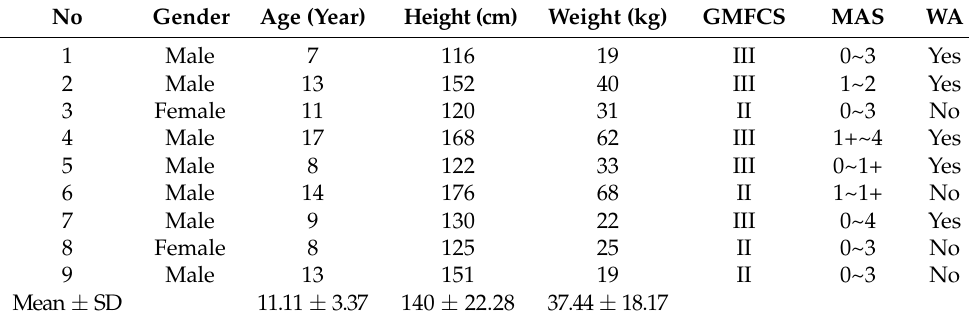
Table 1. Demographic characteristics of the participants.